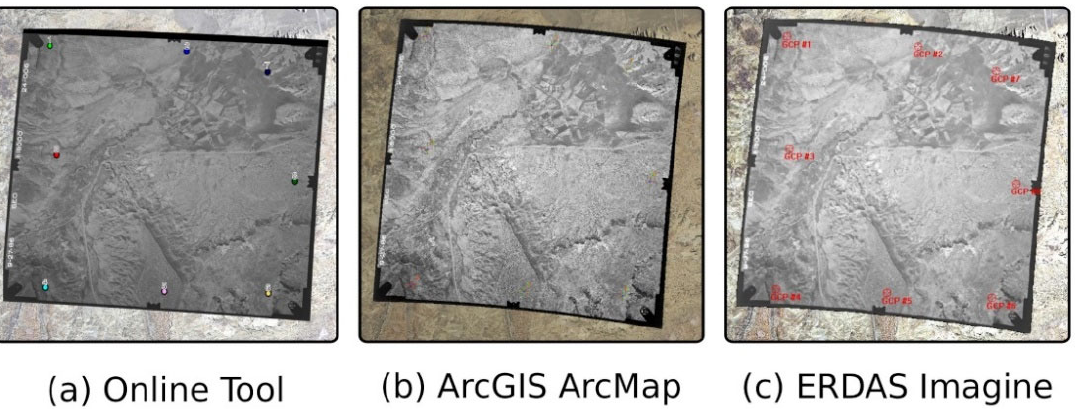
Figure 10. An example of the georeferenced historical aerial photo produced by three georeferencing platforms: ( a ) Online Too; ( b ) ArcGIS ArcMap; and ( c ) ERDS Imagine.